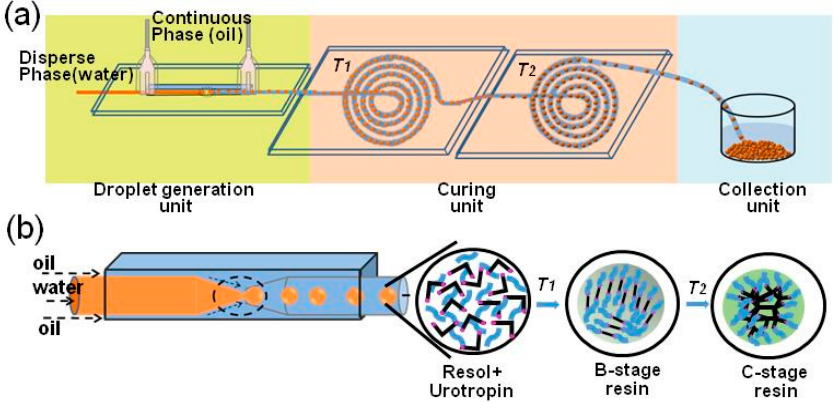
Figure 1. ( a ) Schematic diagram of the formaldehyde resin (RF) microspheres preparation. ( b ) Schematic diagram of the resol inside the droplet during the curing process.